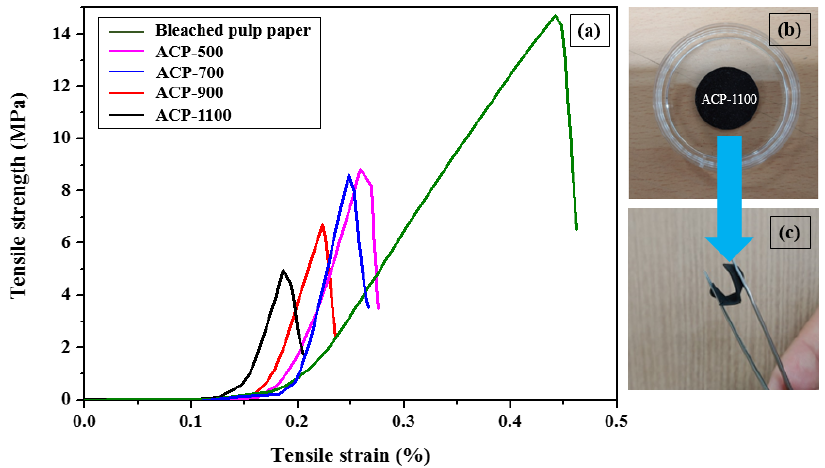
Figure 7. ( a ) Tensile stress–strain curves of the bleached pulp paper of the precursor and ACPs, and photographs of ( b ) ACP-1100 and ( c ) the bent shape of ACP-1100.